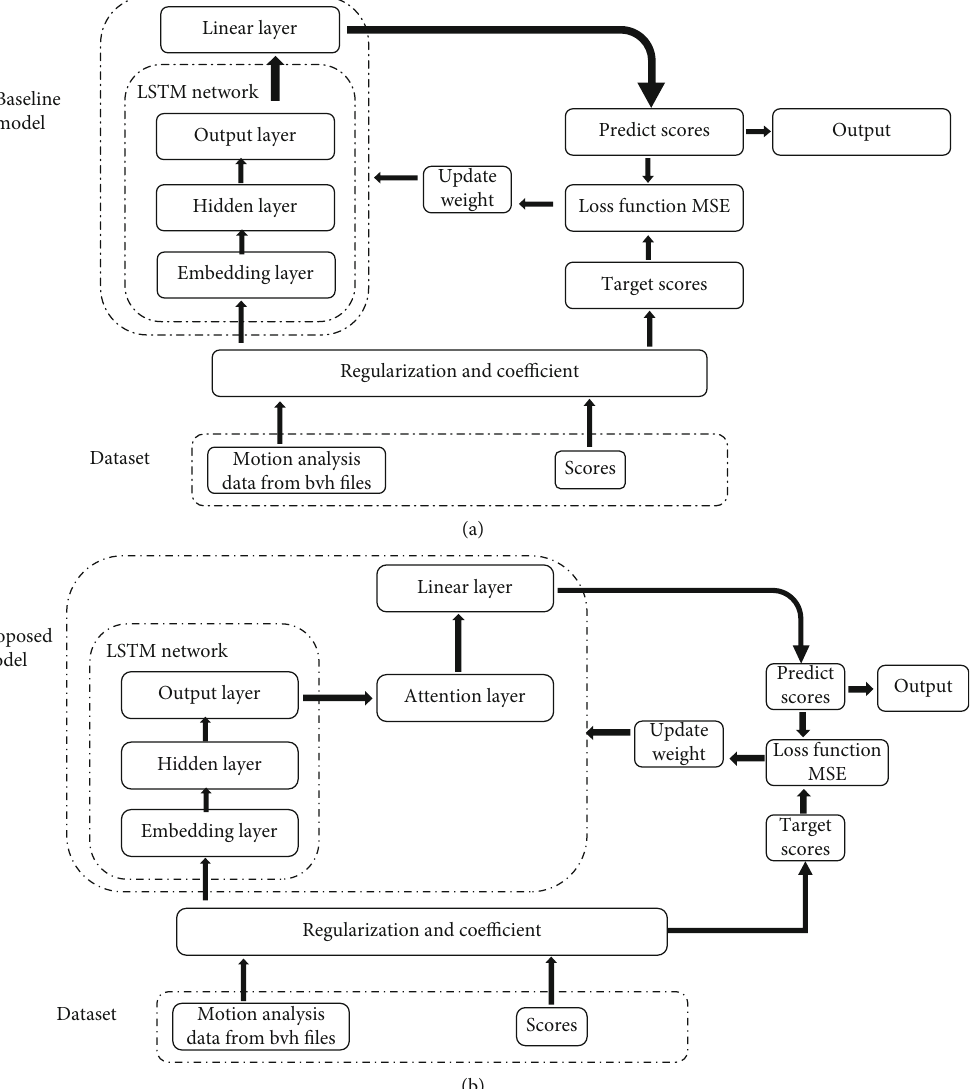
Figure 1: (a) The architecture of the baseline model. (b) The architecture of the proposed